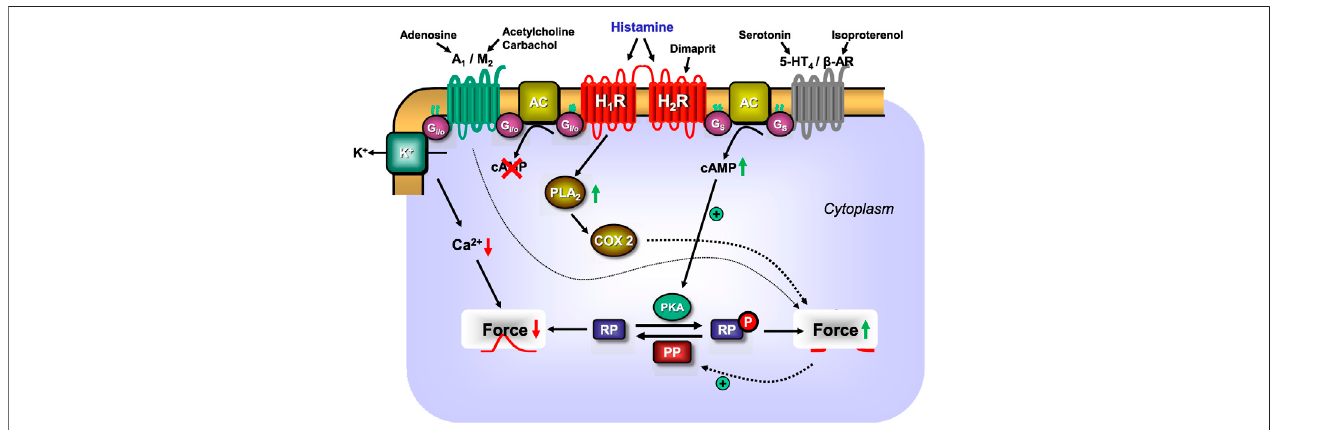
FIGURE2| Scheme:putativemechanismsofinteraction betweenH 1 -orH 2 -histaminereceptorsand otherGTP-binding protein-coupledheptahelicalreceptors in the sarcolemma of a cardiomyocyte. As delineated in Figure 1A , H 2 -histamine receptors after stimulation by endogenous histamine or by the exogenous H 2 -histamine receptor selective agonists like dimaprit will elevate via stimulatory GTP-binding proteins (G s ) the activity of sarcolemmal adenylyl cyclases (AC). Thus, more cAMP is formed and cAMP-dependent protein kinases (PKA) are activated. This leads to a subsequent phosphorylation and activation of cardiac regulatory proteins (RP). Their phosphorylation (compare Figure 1A for details) leads to an increase in force of contraction. The same pathway is used by the cardiac 5-HT 4 -serotonin receptor stimulated by endogenous serotonin or the β -adrenoceptors ( β -AR) stimulated by exogenous isoproterenol to increase cAMP and thereafter force of contraction. The increase of force of contraction induced by histamine by acting on H 2 -histamine receptors is abrogated by additionally acting endogenous compounds like adenosine acting on A 1 -adenosine receptors or endogenous acetylcholine (or exogenous carbachol) stimulating M 2 -muscarinic receptors. Three pathways may be used by M 2 - muscarinic receptors and A 1 -adenosine receptors. They may inhibit via inhibitory G-proteins (G i/o α ) the activity of AC, thereby reduce cAMP content and thus decrease force of contraction. In addition, A 1 -adenosine and M 2 -muscarinic receptors can activate sarcolemmal potassium ion channels: this shortens the duration of the action potential;lesstimeisavailablefortriggerCa 2+ toenterthecellviaL-typeCa 2+ channels(see Figure1A ),cytosolicCa 2+ declinesandforcefalls.Lastly,M 2 -muscarinicand A 1 -adenosine receptors may directly or indirectly activate protein phosphatases (PP, see Figure 1A ) which would reduce the phosphorylation state and subsequently the force in the myocardium. Moreover, as shown in Figure 1B , H 1 -histamine receptors, may activate phospholipase A2 (PLA 2 ), thereby activating cyclooxygenase 2 (COX2) which generates metabolites of arachidonic acid which can elevate force of contraction. Finally, there seems to be a direct interaction whereby the H 2 -receptor stimulation can reduce the activity of the H 1 -histamine receptor.